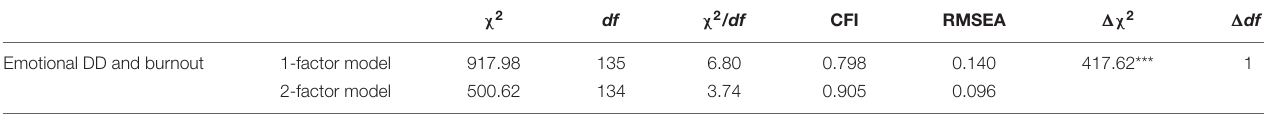
TABLE 4 | Results of the confirmatory analyses testing the distinctions between emotional diabetes-related problems and symptoms of stress, respectively burnout. χ 2 df χ 2 / df